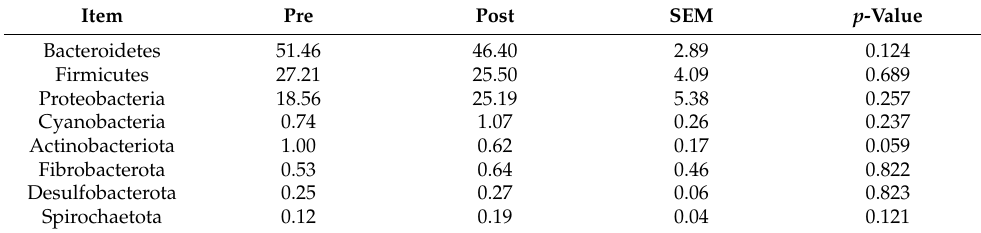
Table 5. Rumen bacterial community at the level of phylum before (Pre) and after (Post) diet shift.